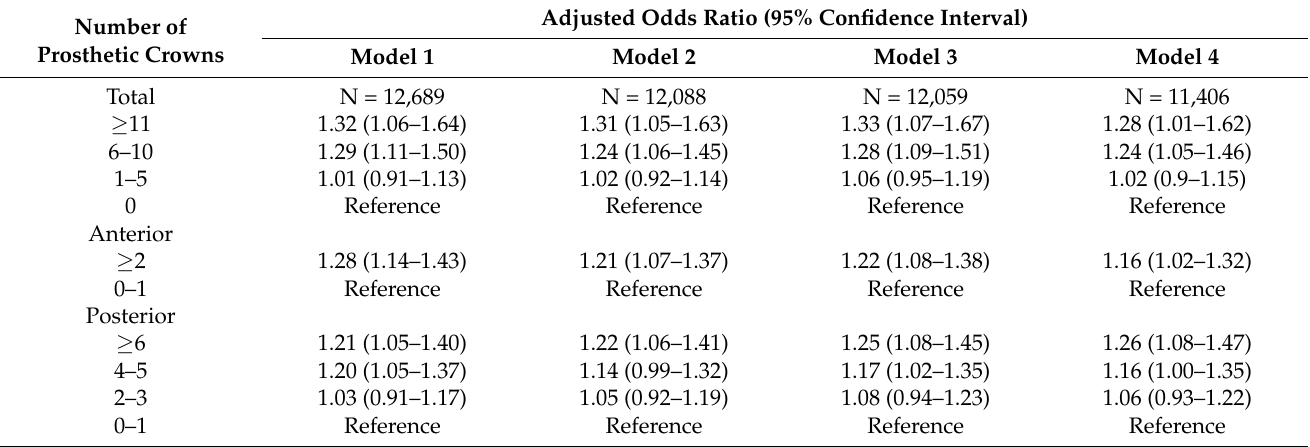
Table 2. Multivariable association between the number of prosthetic crowns and